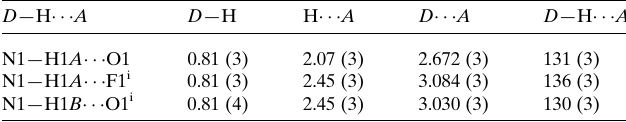
Table 1 Hydrogen-bond geometry (A˚ , (cid:2)